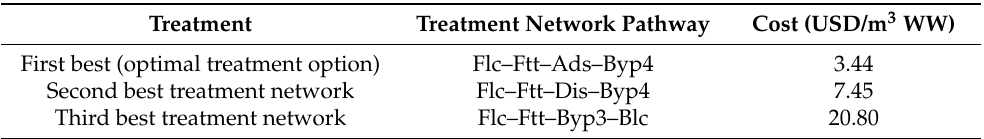
Figure 7. Percentage distribution of the various cost categories for pharmaceutical WWT case study. Other costs from the primary stage dominated the overall cost of treatment. Table 8. The second and third best treatment options for pharmaceutical WWT. There is a 53.8% increase in the second-best option, and 83.5% increase in the third-best option concerning the optimal treatment